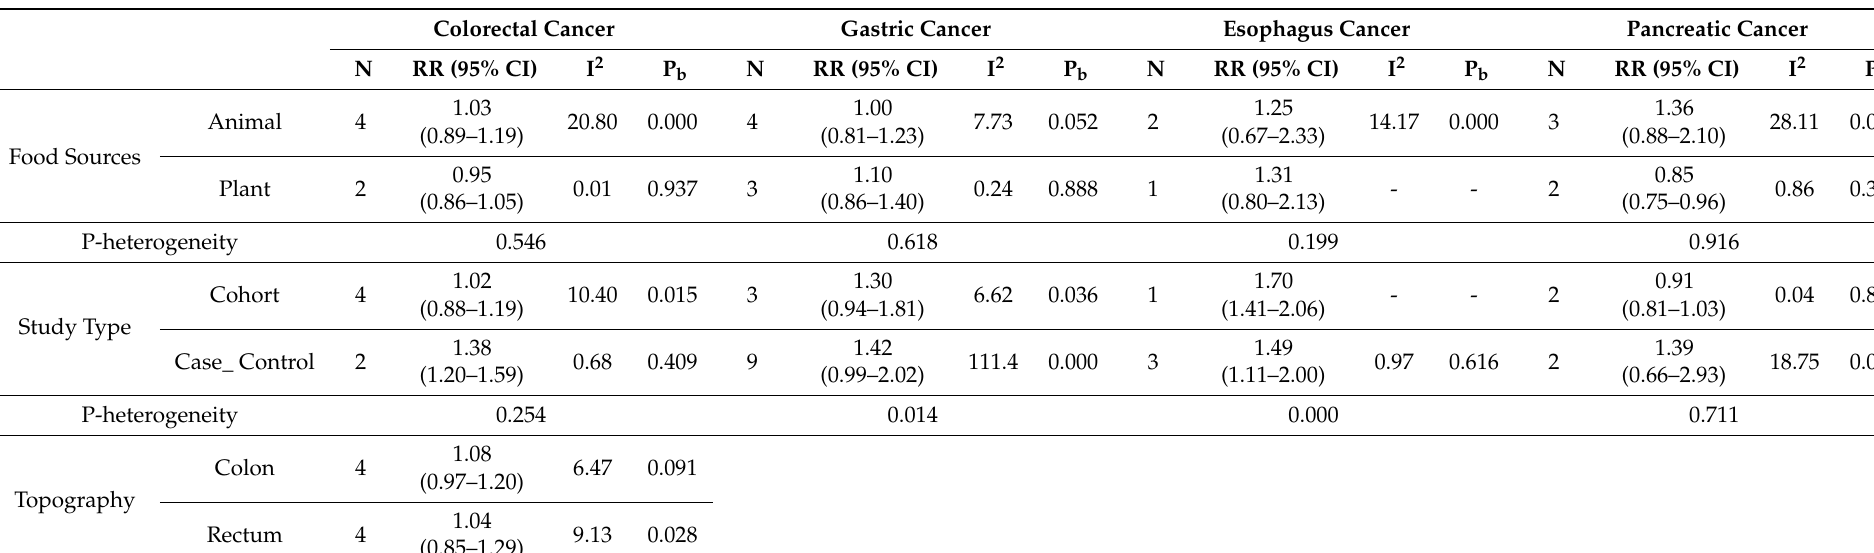
Table 2. Association between nitrite intake and selected gastrointestinal cancers stratified by gender, food sources, study type, and